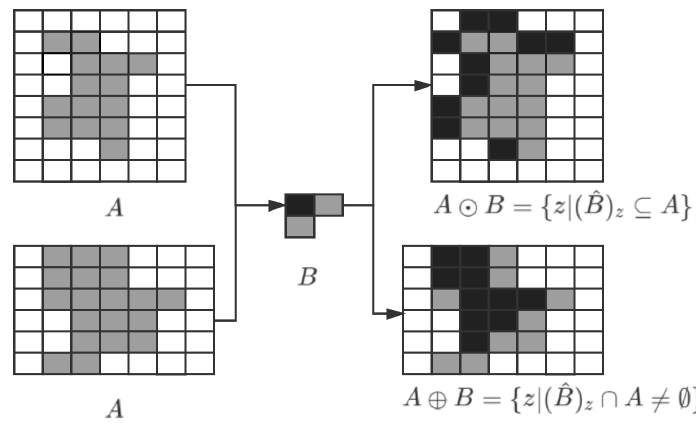
Figure 3. Processing of dilation and erosion.